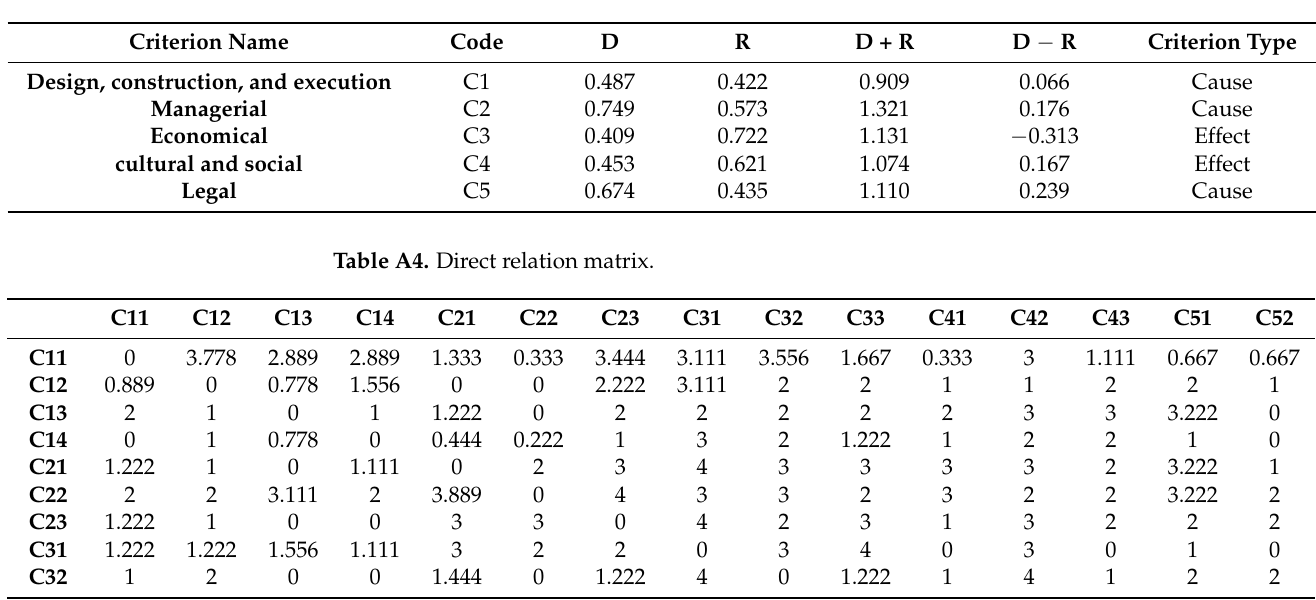
Table A3. Determining influential and influenced dimensions during DANP computations.